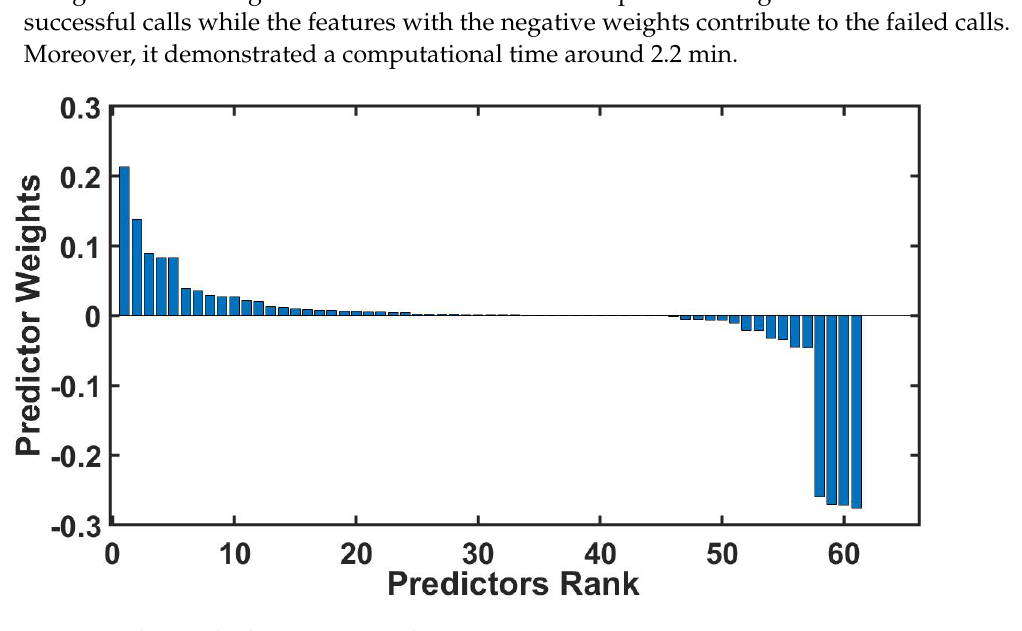
Figure 9. Filter method: Features